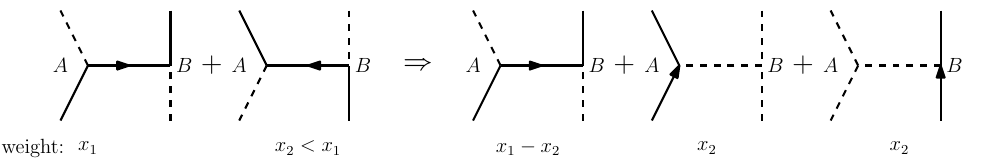
Figure 19 . Having two flows passing through an edge and its opposite orientation can be replaced by the flows shown in the figure, resulting in the same flow, but passing in only one of the directions of that